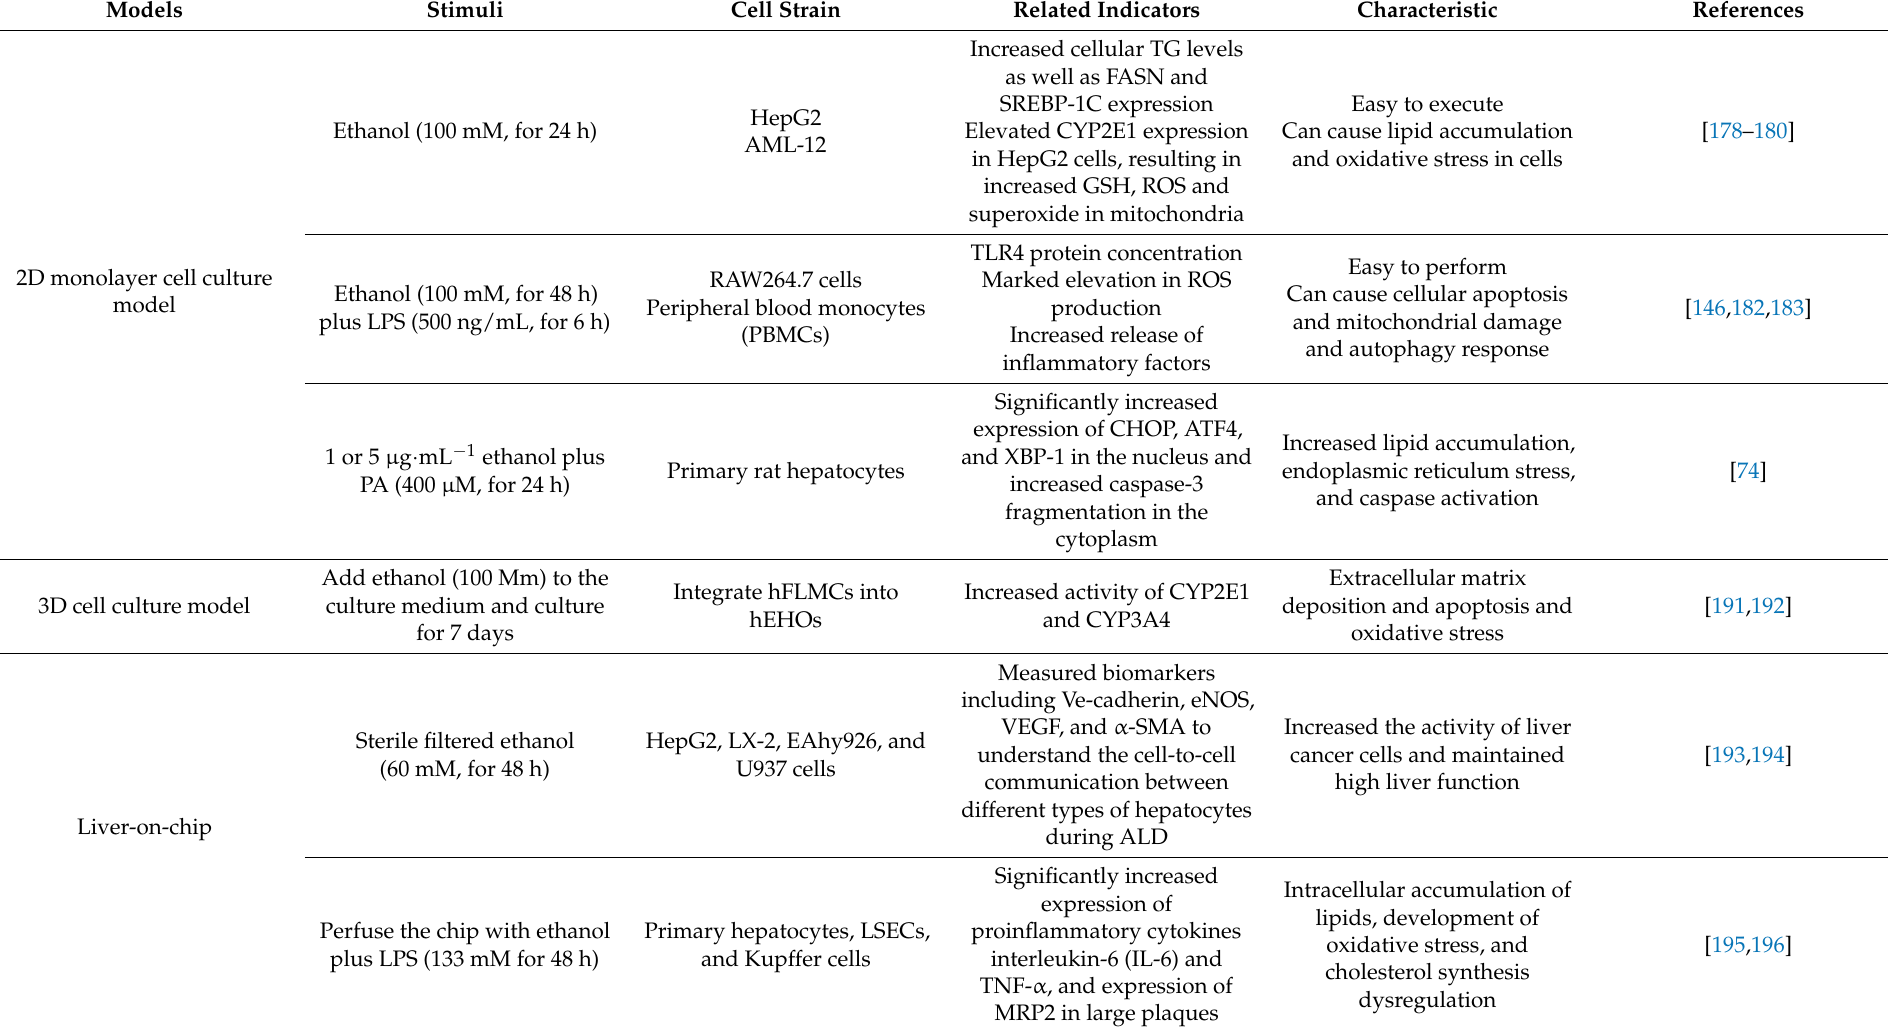
Table 2. Comparison of models of alcohol-associated liver disease in